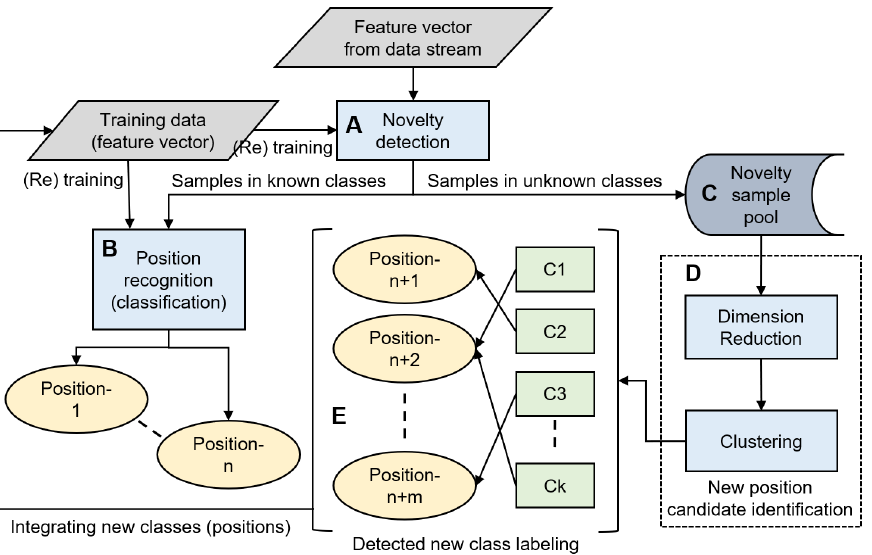
Figure 1. Framework of the incremental addition of smartphone carrying positions. ( A ) Novelty detection, ( B ) position recognition, ( C ) novelty sample pool, ( D ) new position candidate identification, and ( E ) detected new class